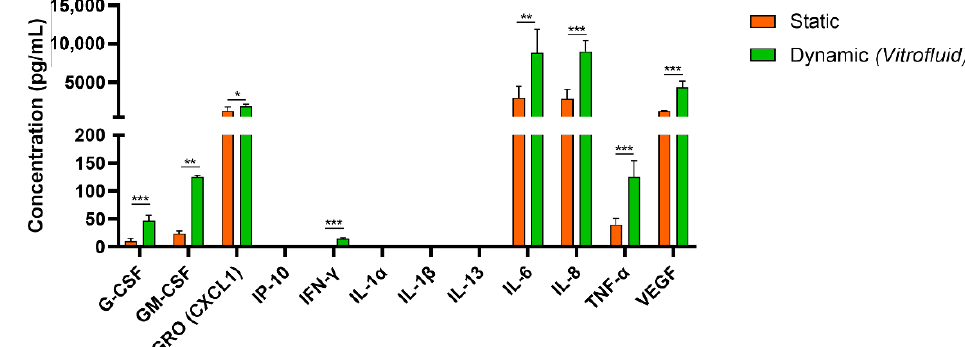
Figure 4. Cytokine secretion profile from RPTECs under static and dynamic conditions (day 7): Released cytokines were evaluated using a Luminex assay (mean ± SD; n = 2 biological repeats in technical triplicates; Student’s t -test; * p ≤ 0.05, ** p ≤ 0.01, *** p ≤ 0.001).